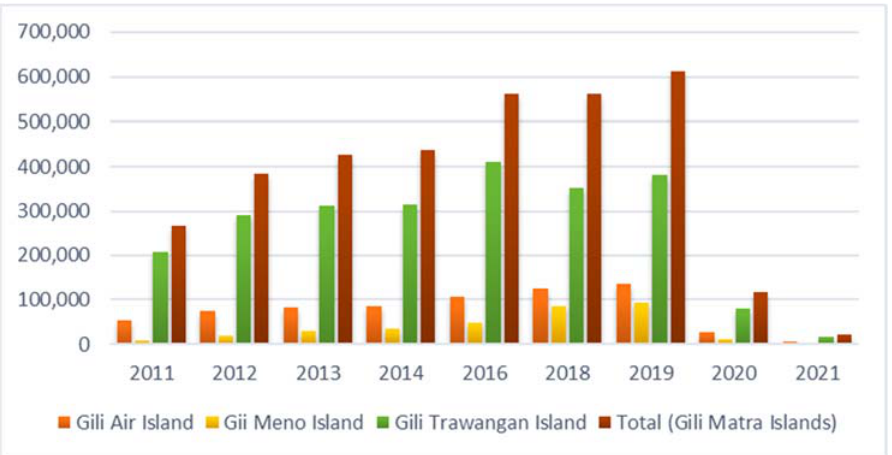
Figure 2. Tourists increased in Gili Matra Islands. Adapted with permission from Ref [30,31]. 2021, Dept. of Tourism.